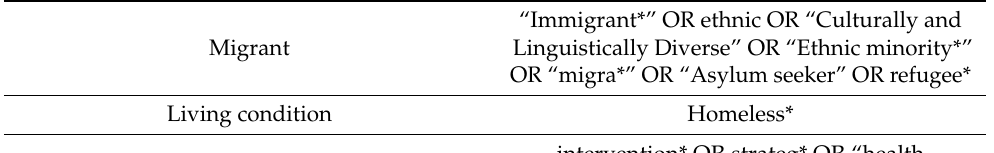
Table 2. MeSH Search